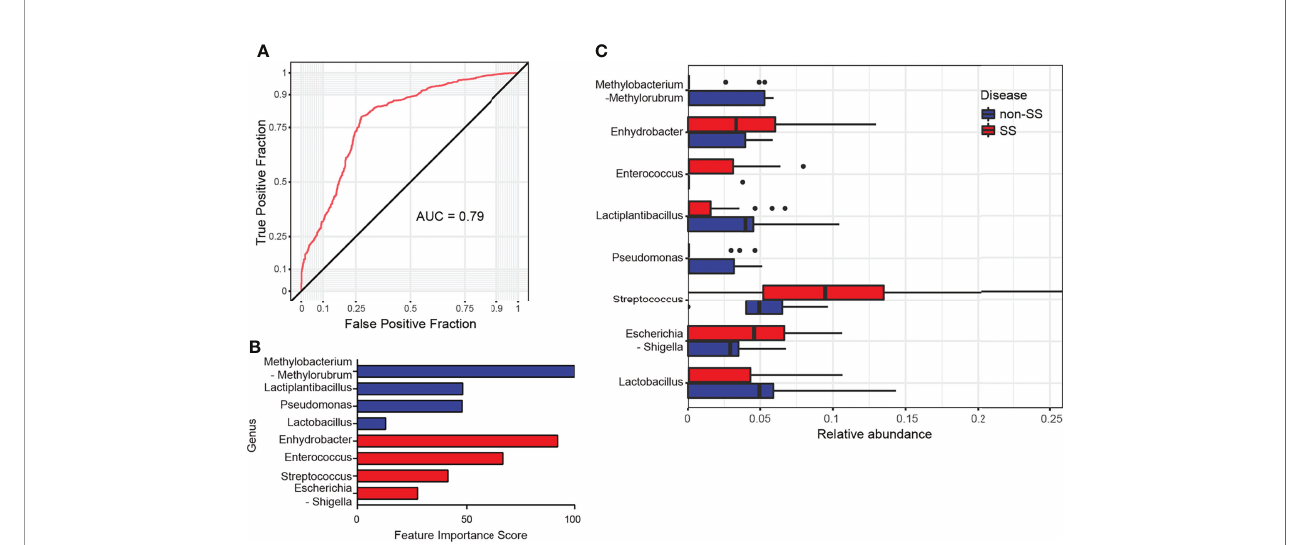
FIGURE 5 | Microbiome features predicted with logistic regression as supervised learning classi fi cation algorithm. (A) Receiving operating characteristic curve of logistic regression using eight genera. The diagonal line represents an area under the curve value of 0.5, which was a random decision. (B) The feature importance scores of the top eight genera used in logistic regression were illustrated. Blue bars indicate non-Sjögren ’ s syndrome (SS) group-speci fi c genera, while red bars indicate SS group-speci fi c genera. (C) The relative abundance of the eight genera used in logistic regression was comparatively analyzed between non-SS and SS